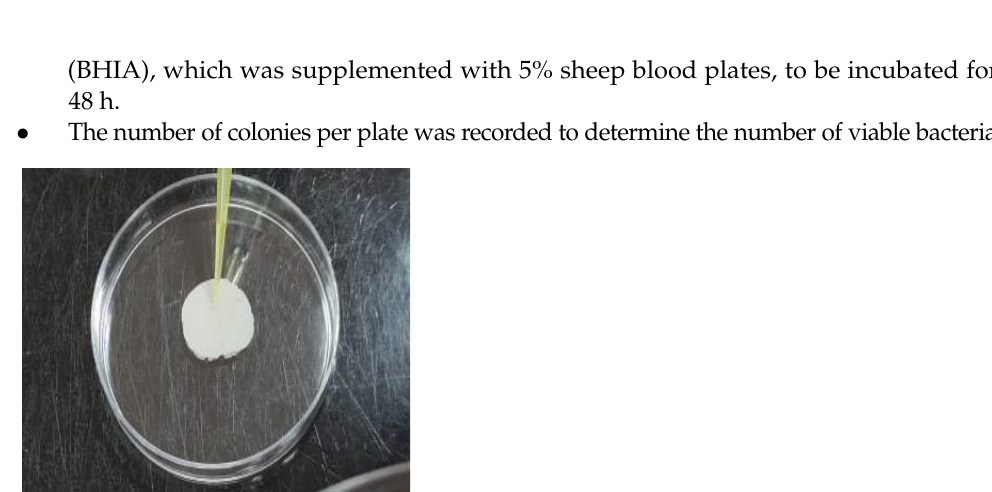
Figure 3. Direct contact test on a disk-shaped orthodontic composite sample. The X-ray diffraction diagram of magnesium oxide nanoparticles is displayed in Figure 4, which is consistent of their X-ray diffraction pattern from other reference [31].